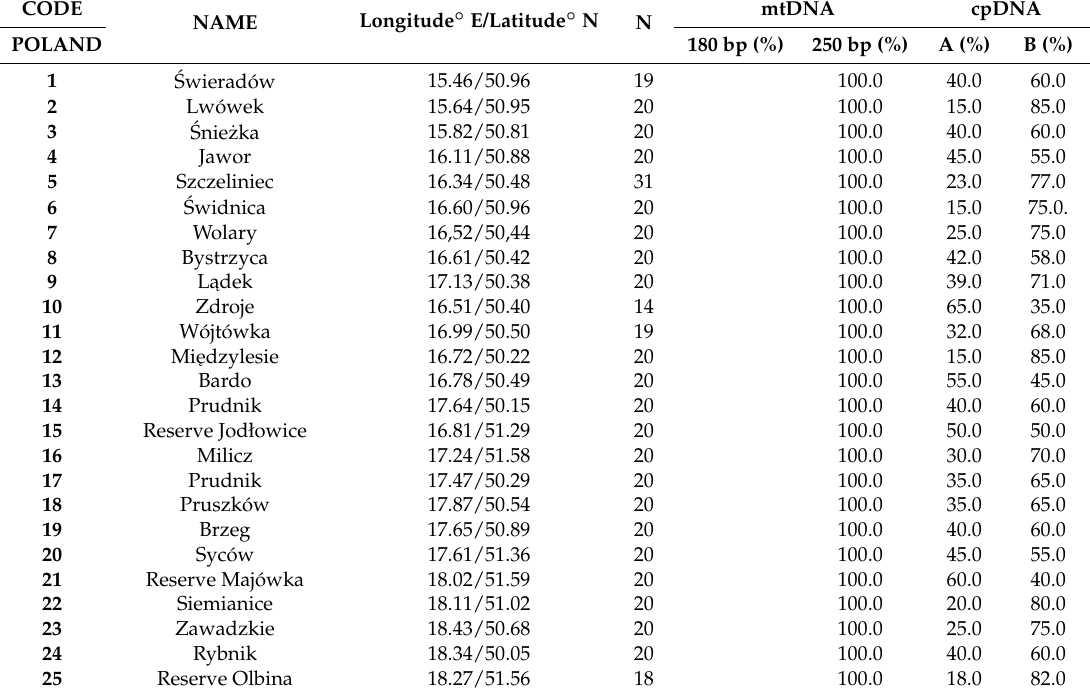
Figure 2. Locations of the 81 populations of Abies alba included in this study and the distribution of the haplotypes in the chloroplast psbC marker. The population codes and details on the frequency of occurrence of haplotypes A (dark circle, Balkan refugium) and B (grey circle, Apennine refugium) are shown in Table 1. The border of the natural distribution of A. alba in Poland is indicated with a wavy black line. Table 1. Sample descriptions of Abies alba populations included in this study and the distribution of frequency (%) of mitochondrial ( nad5-4 ) and chloroplast ( psbC ) haplotypes in these populations.